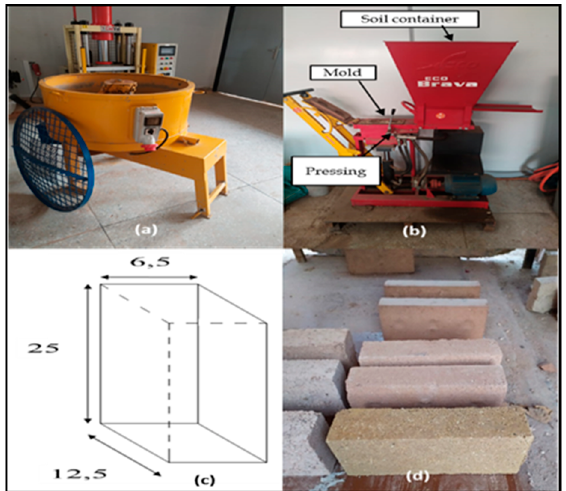
Figure 3. ( a ) Mixer; ( b ) Brava machine; ( c ) Mold dimensions in cm; ( d ) CEB samples.